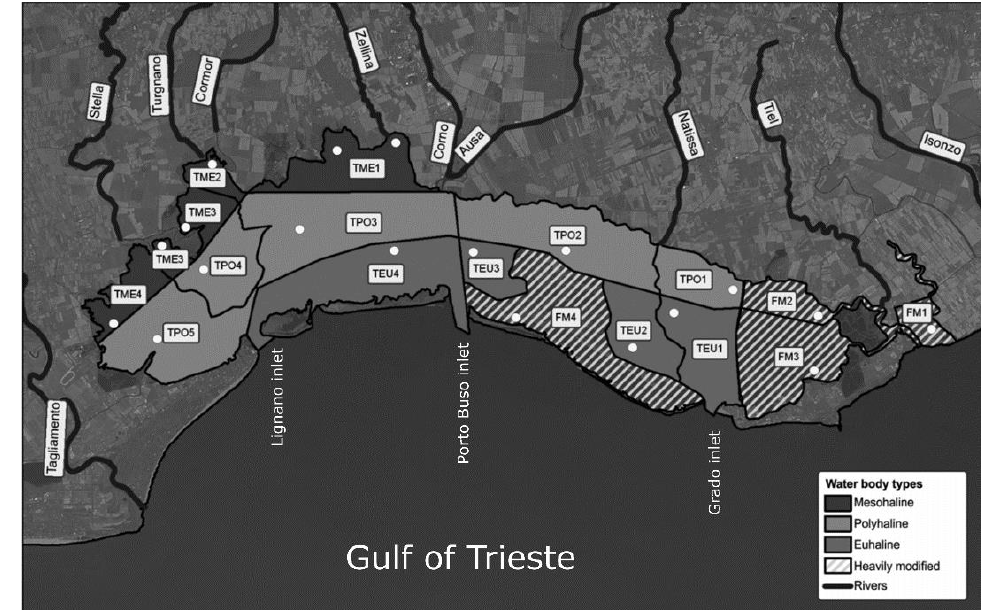
Figure 1. Index map of the Marano and Grado Lagoon with the identified water bodies.